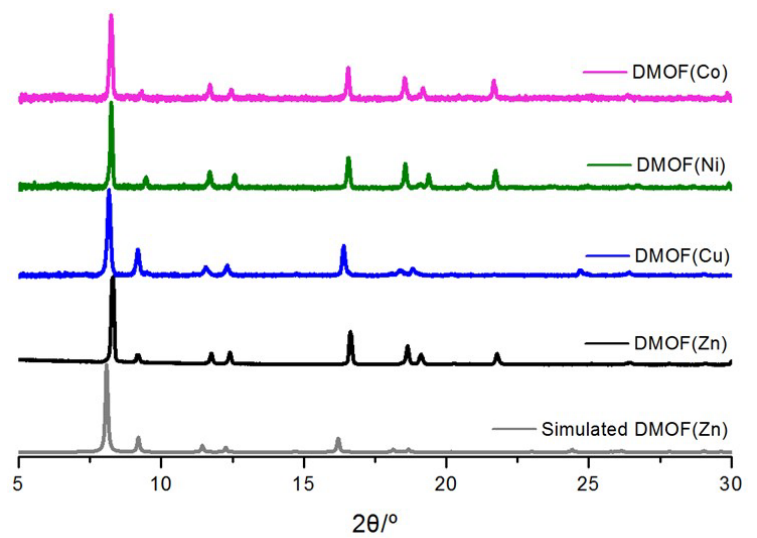
Figure 2. Powder X-ray diffraction (PXRD) patterns of DMOFs with different metal sources. With DMOF(Zn) and the optimized conditions, the effect of the functional group on the BDC ligand was studied next (Table